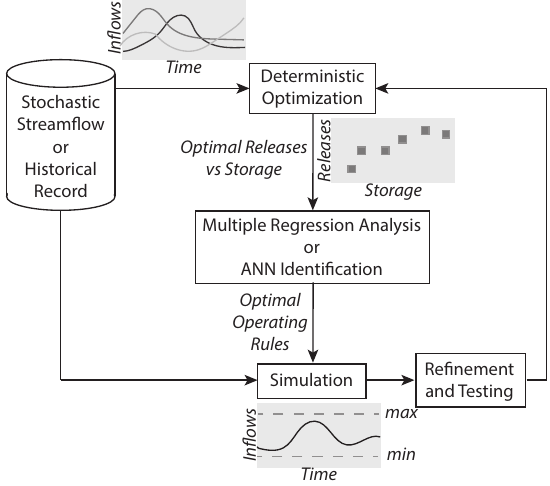
Figure 1. Schematic representation of the ISO procedure (modified from [14]). First, the optimal open-loop decisions are computed. Then, the obtained dataset is used for the identification of the closed-loop